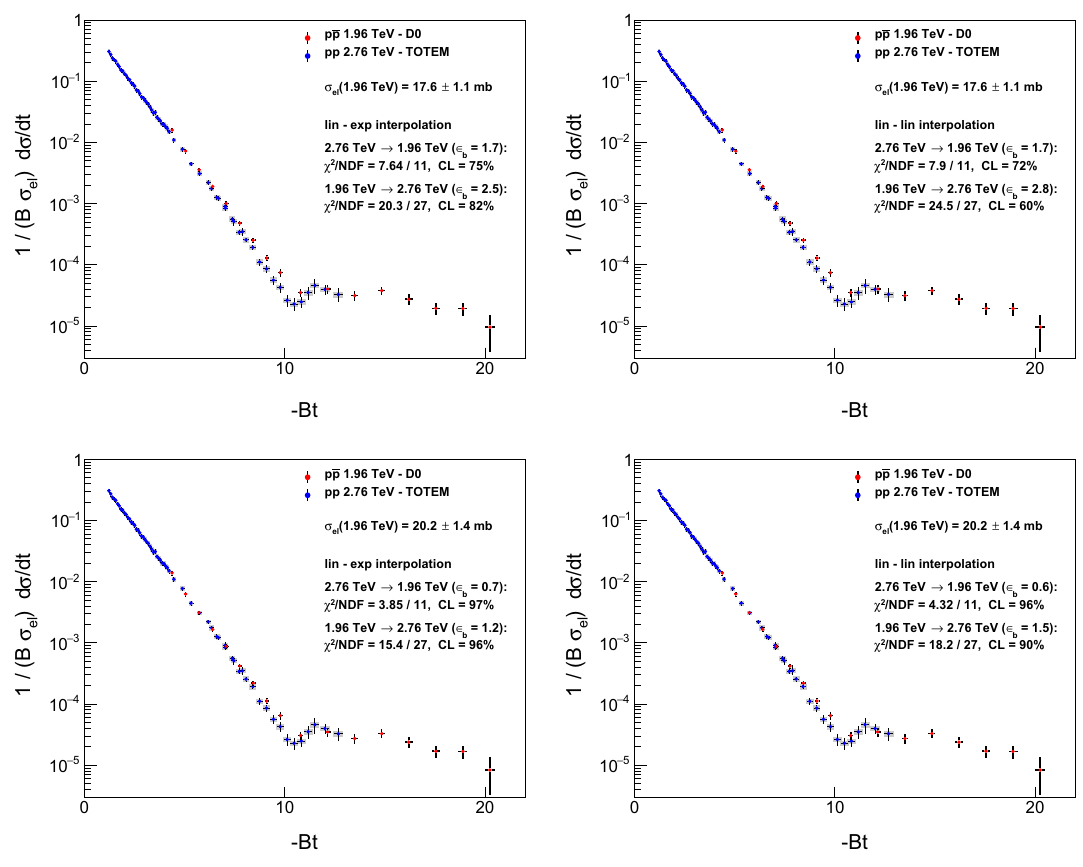
Fig. 12 Lack of a significant Odderon signal in the comparison of the search are summarized in Table 3. See also Table 5 for a summary of H ( x ) scaling functions of the differential cross section of elastic pp the results of the two-way comparisons of these H ( x ) scaling functions. √ s = 2 . 76 TeV, measured by the TOTEM [4], to that of collisions with Top-leftpanel:Using σ el = 17 . 6 ± 1 . 7mbandalinear-exponentialinter- √ p ¯ p collisions with s = 1 . 96 TeV, measured by D0 [8]. The correla- polation method. Top-right panel: Same as the top-left panel but for a linear-linear interpolation in ( x , H ( x )) . Bottom-left panel: Same as the tion coefficient of the | t | -dependent systematic errors, (cid:13) b , is optimized top-left panel but for σ el = 20 . 2 ± 1 . 4 mb. Bottom-right panel: Same as to minimize the χ 2 based on Eq. (63), and the value indicated on the plot corresponds to the minimum of χ 2 ((cid:13) b ) . The results of our Odderon the bottom-left panel but for a linear-linear interpolation in ( x , H ( x